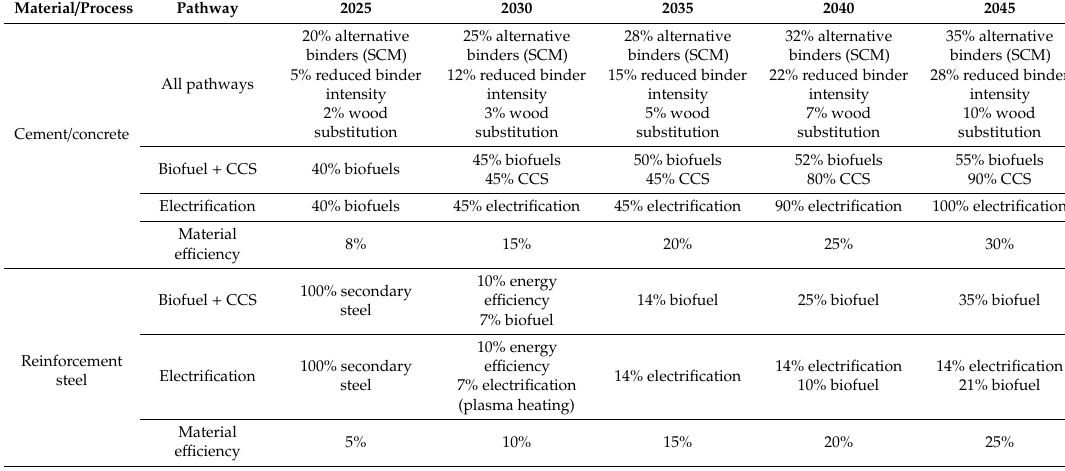
Table 2. Details of abatement measures applied across pathways with percentage figures depicting the di ff usion of the specific mitigation